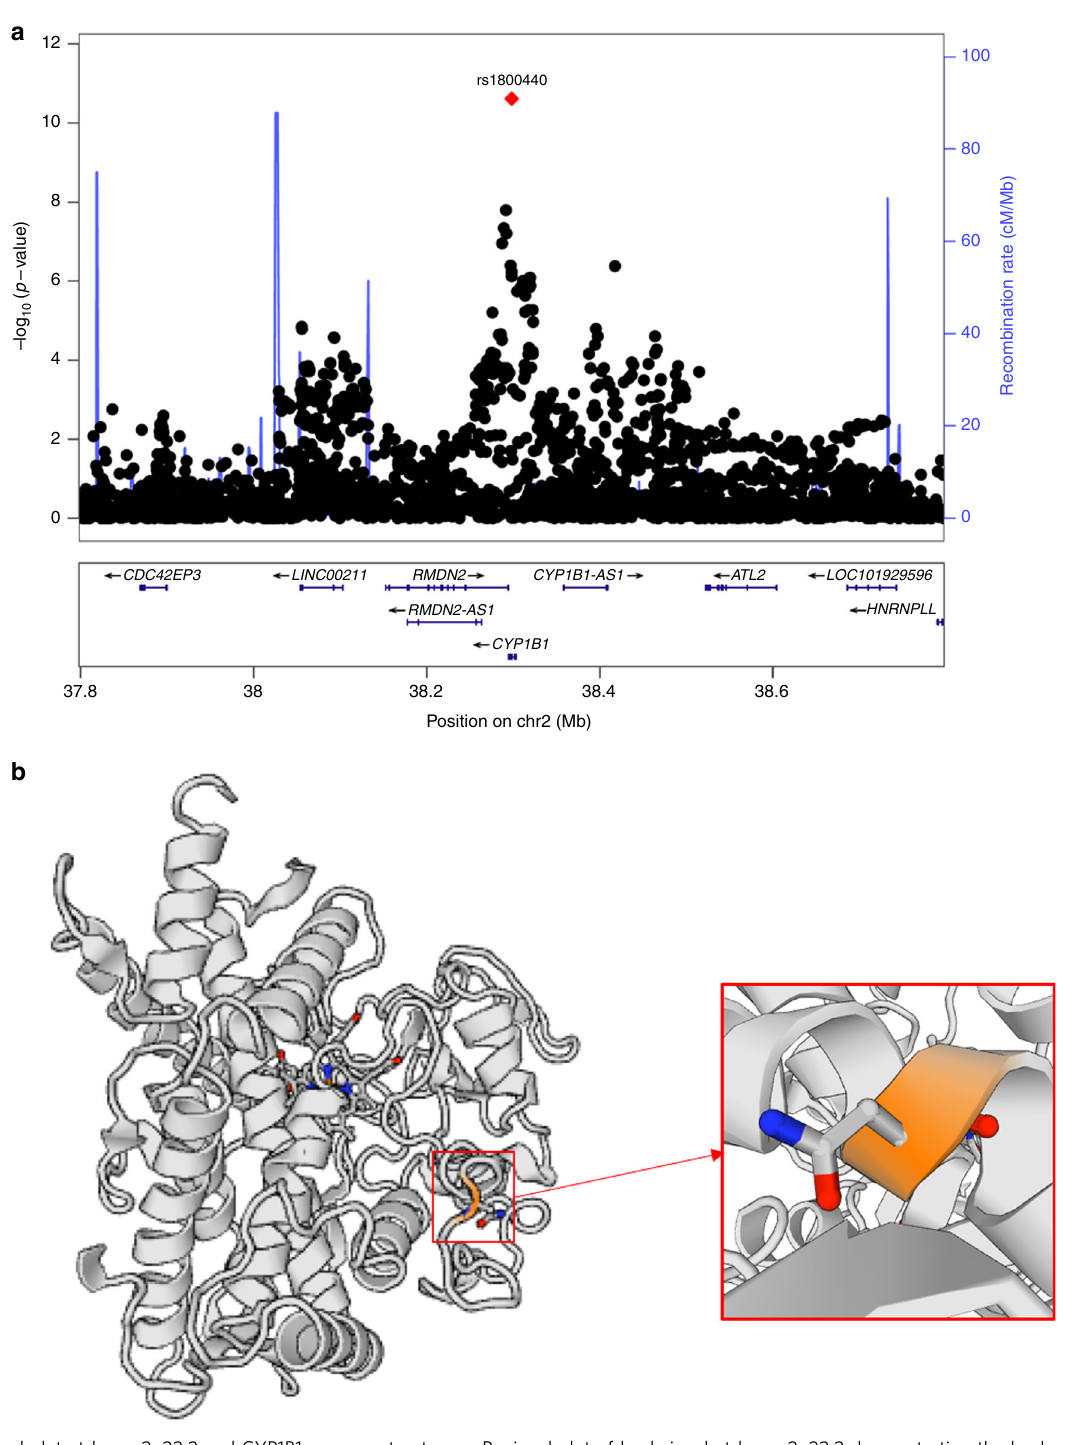
Fig. 4 Regional plot at locus 2p22.2 and CYP1B1 enzyme structure. a Regional plot of lead signal at locus 2p22.2 demonstrating the lead causal variant (rs1800440); the blue lines shows the fi ne-scale recombination rates (right y axis) estimated from individuals in the 1000 Genomes population; genes are highlighted with horizontal lines; the x axis shows the chromosomal position in Mb; variants within the 95% credible set are highlighted in red ( N = 1, posterior probability = 0.98); b CYP1B1 enzyme structure drawn via the SWISS-MODEL repository with the site affected by the residue change from Asparagine (N) to Serine (S) at position 453 magni fi ed